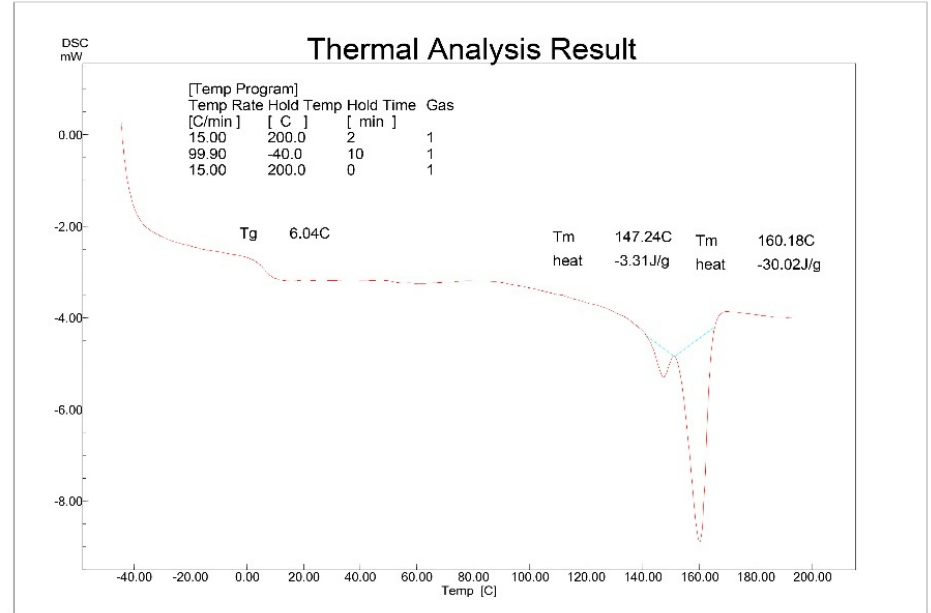
Figure 4. Differential Scanning Calorimetry (DSC) of P(3HB- co -2 mol% 3HHx) produced by C. necator PHB − 4/pBBR_CnPro- phaC Rp .